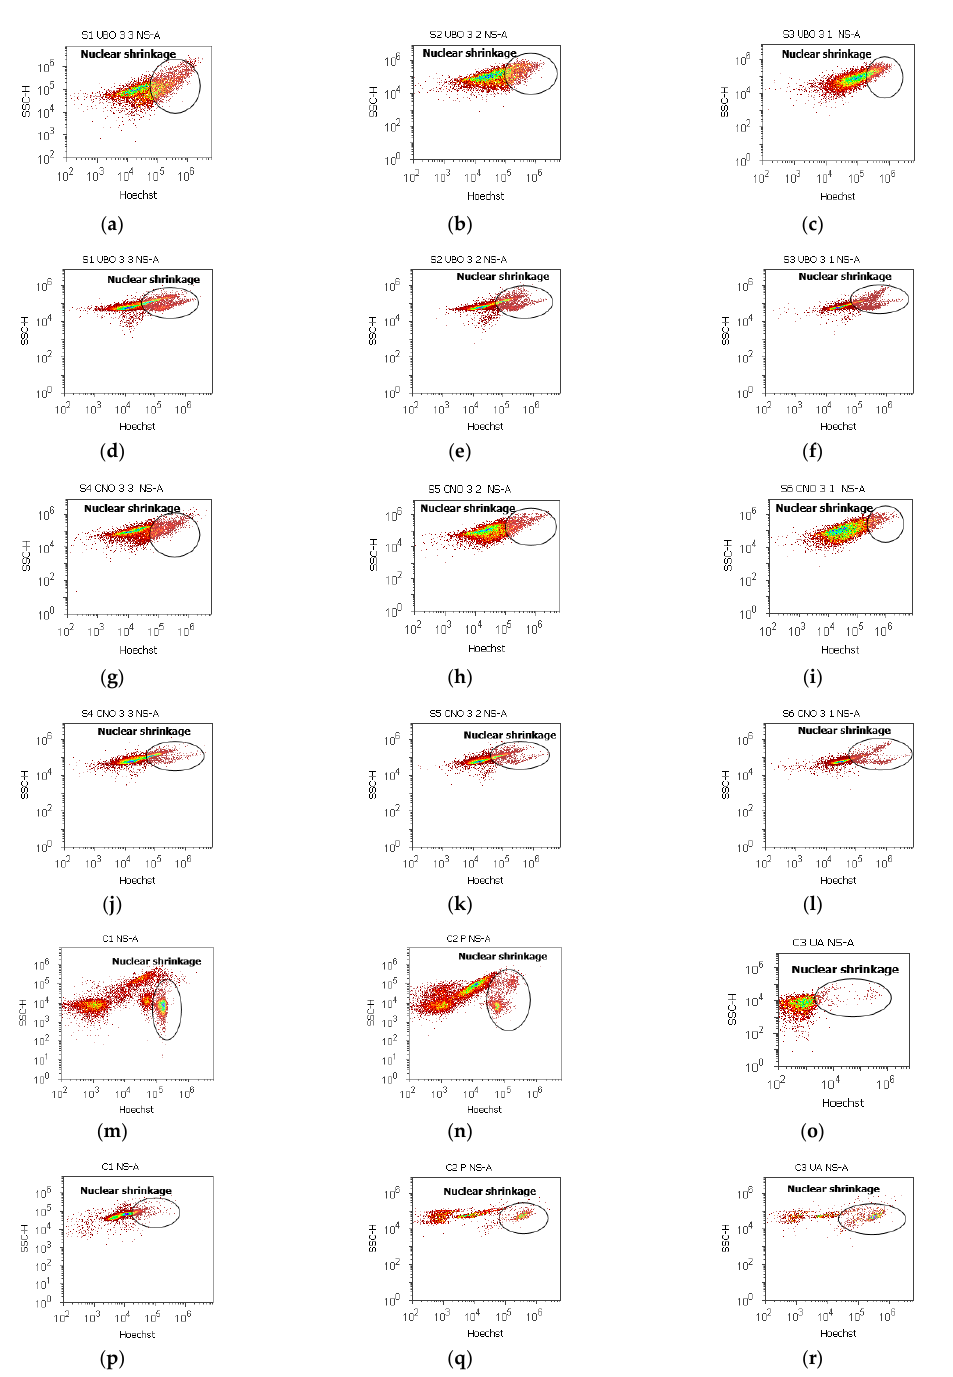
Figure 7. Nuclear shrinkage in blood cells ( a – c , g – i , m – o ) and CLS-354 tumor cells ( d – f , j – l , p – r ) after 24 h exposure to different concentrations [3:3; 3:2; 3:1] of U. barbata extract in canola oil (UBO) ( a – f ) and canola oil (CNO) ( g – l ) compared to C1, C2P, and C3UA controls ( m – r ). C1—1% DMSO (negative control), C2P—5% Poloxamer 407 (positive control), C3UA—usnic acid (positive control), NS—nuclear shrinkage, A—autophagy. [3:3; 3:2; 3:1]—culture medium/sample ratio ( v / v